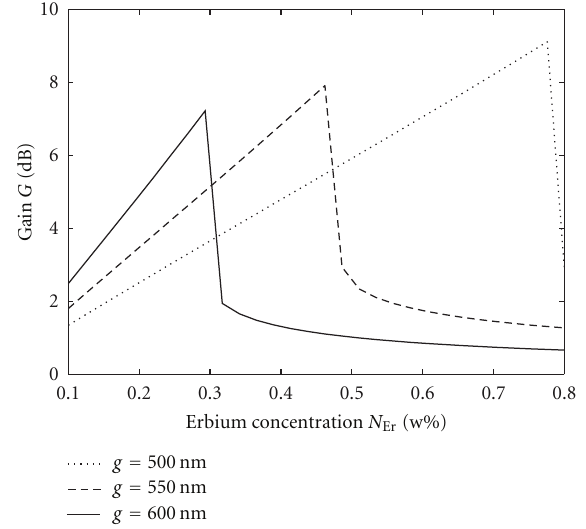
Figure 6: Signal amplification as a function of the erbium concen- tration for three di ff erent values of fiber